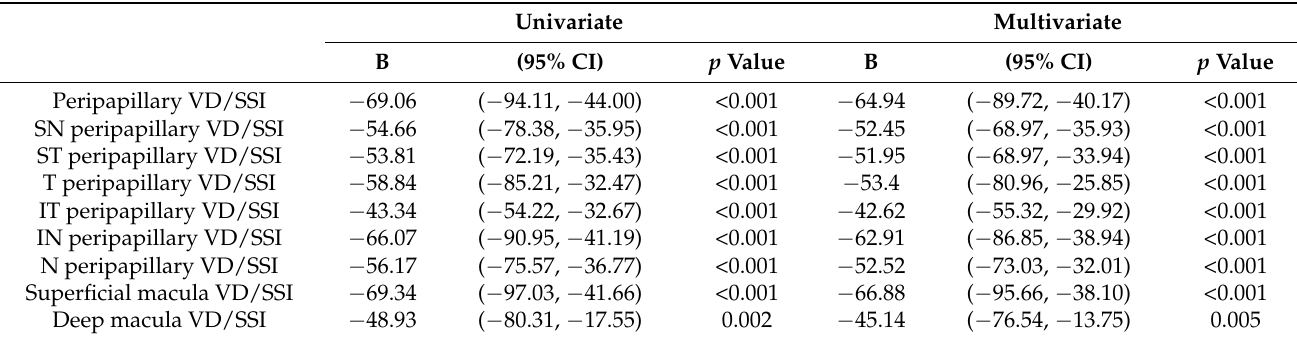
Table 3. Significant initial vessel density/SSI related to the change percentage of peripapillary vessel density/signal strength index after 6-month carteolol treatment in normal-tension glaucoma patients.